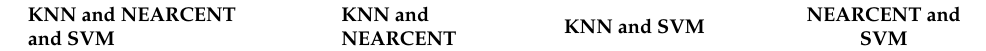
Table 14. Common metabolites found in each model for Control-Nephropathy. KNN and NEARCENT and SVM